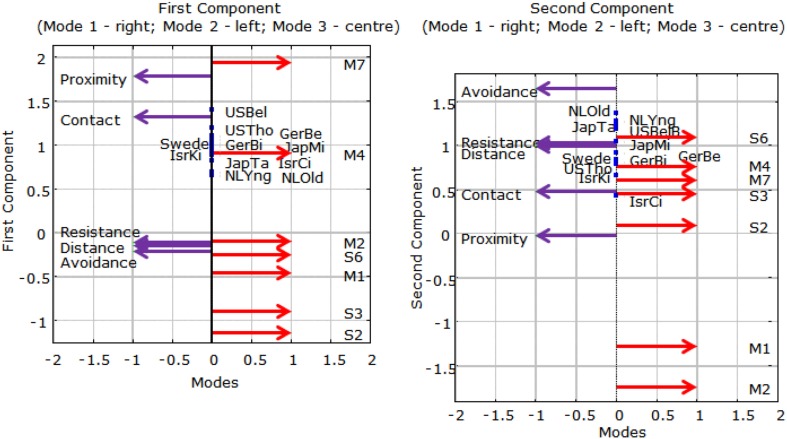
Two-component Parafac analysis: Invariant components plus link strength of samples. Mi = Mother episode i; Si = Stranger episode i. For sample abbreviations, see Figure 3.